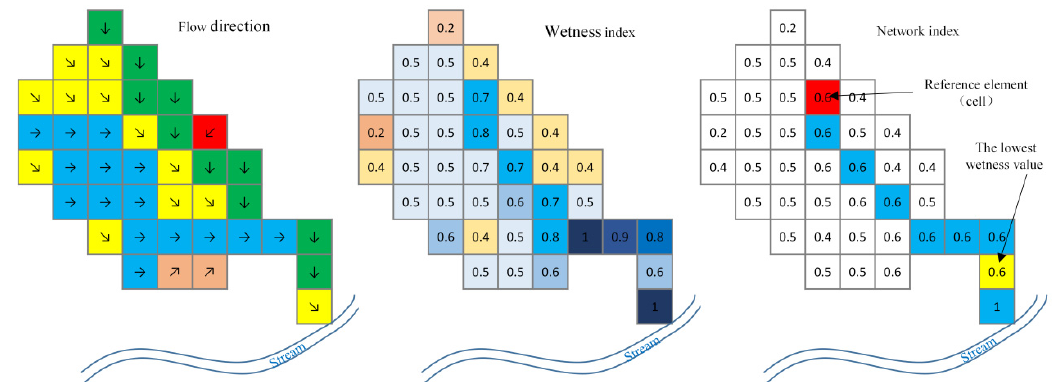
Figure 2. Schematic diagram of network index (NI) calculation.